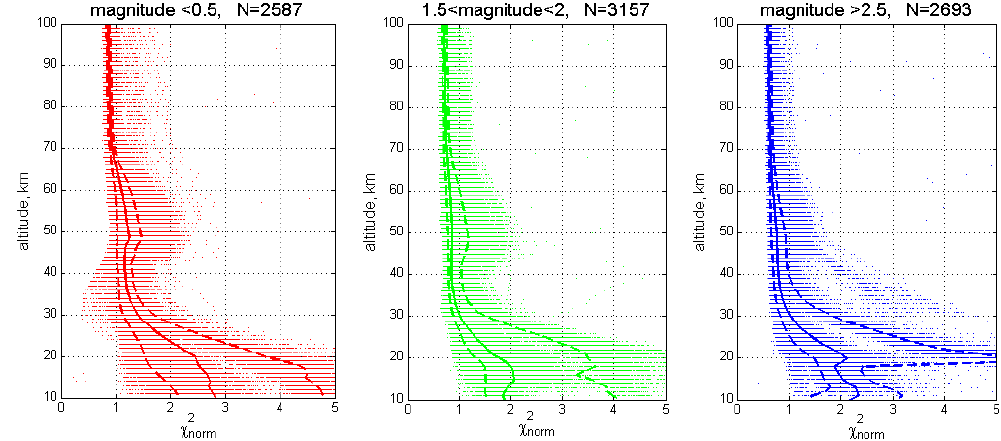
Figure 1. χ 2 norm for stars of different magnitudes. Dots: individual values, solid lines: median profiles, dashed lines: 16th and 84th percentiles. Number of occultations is specified in the figure. The 2008 data in the Northern Hemisphere are